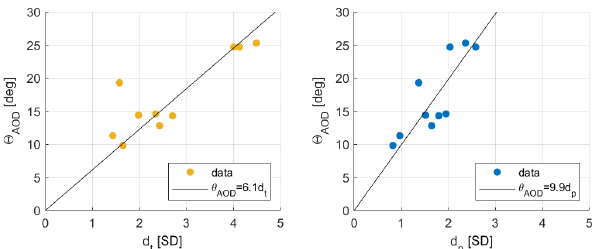
Figure 8. (a) Angle between AOD patterns, θ AOD , and the distance between corresponding temperature responses, d t , for each pair of strategies in Table 1; (b) angle between AOD patterns, θ AOD , and the distance between corresponding precipitation responses, d p , for each pair of strategies in Table 1. d t and d p are expressed in the number of SDs of 20-year averages of temperature and precipitation respectively. Orange dots represent the values of θ AOD and corre- sponding d t and blue dots represent the values of θ AOD and corre- sponding d p of all pairwise comparisons between different strate- gies. The black lines represent the best-fit linear regression func- tions, constrained to pass through the origin: θ AOD = 6 . 1 d t , and θ AOD = 9 . 9 d p with the coefficient of determination, R 2 t = 0 . 62 and R 2 p = 0 . 65, respectively. The error in estimating each point (calcu- lated from across-ensemble variability) is small (less than 0.2 ◦ in AOD angle, and less than 0.1SD in both temperature distance and precipitation distance) compared to the fitting error, indicating that a linear approximation to the relationship is only an approximation. Points in the upper right (most dissimilar AOD and dissimilar sur- face climate) are the pairwise comparisons between the equatorial injection strategy and the other strategies. In panel (a) , the outlier at approximately (1.6, 19), which is the comparison between iSpring and iAutumn, shows that the relationship between θ AOD and d t is not exactly linear; similar AOD patterns yield similar climate re- sponses but different AOD patterns do not guarantee different cli- mate